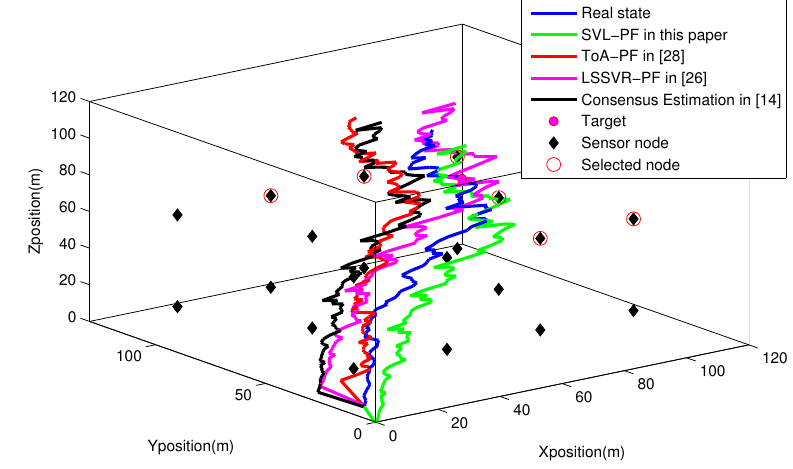
Figure 6. The localization trajectory of the proposed algorithm and the compared algorithms in the excessive noise condition.